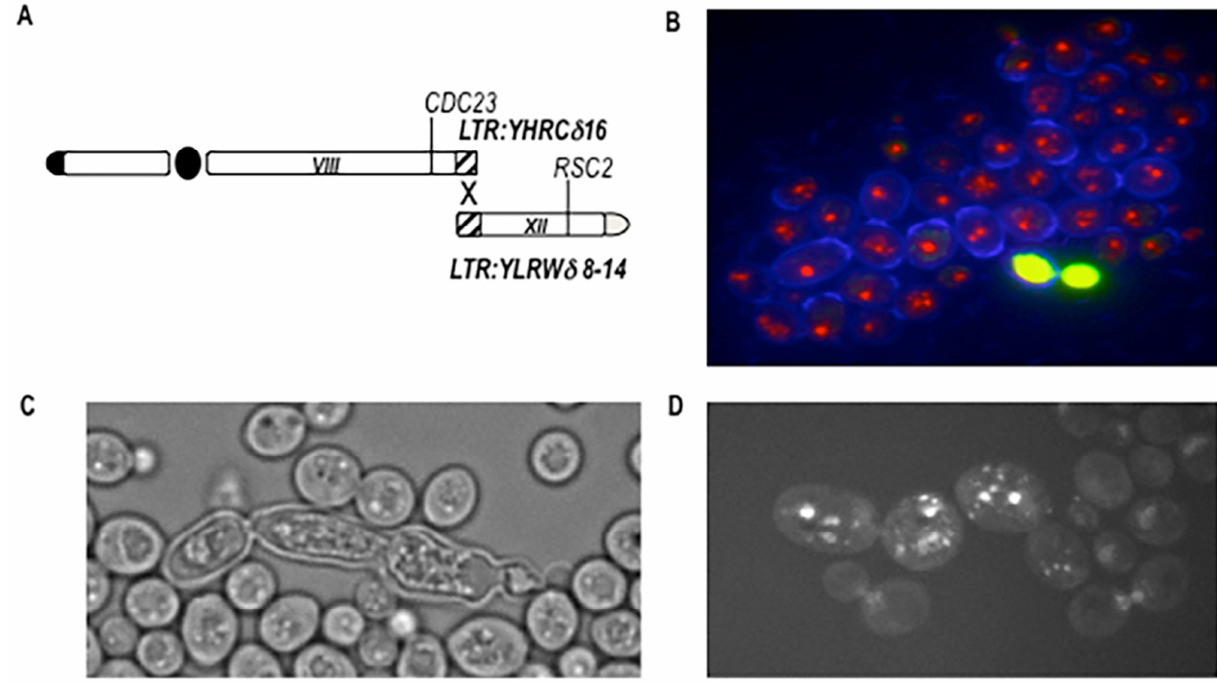
FIGURE 3: Analysis of a BIT-translocant over-expressing RAD54 . (A) Scheme of a further rearrangement event following a primary BIT translocation (represented in Fig. 2A). Two almost identical LTRs, one on the right arm of chromosome VIII and another on the right arm of chromosome XII, recombine leading to a new translocation between chromosome VIII and XII (scheme adapted from [65]). (B) In BIT translocants over-expressing RAD54 , many dead cells are present. Live/Dead staining (Molecular Probe), here combined with Calcofluor, shows the presence of dead cells (in yellow). (C) Abnormal phenotype of dead BIT translocants over-expressing RAD54. (D) DAPI staining indicates severe nuclei fragmentation when RAD54 is over-expressed in BIT